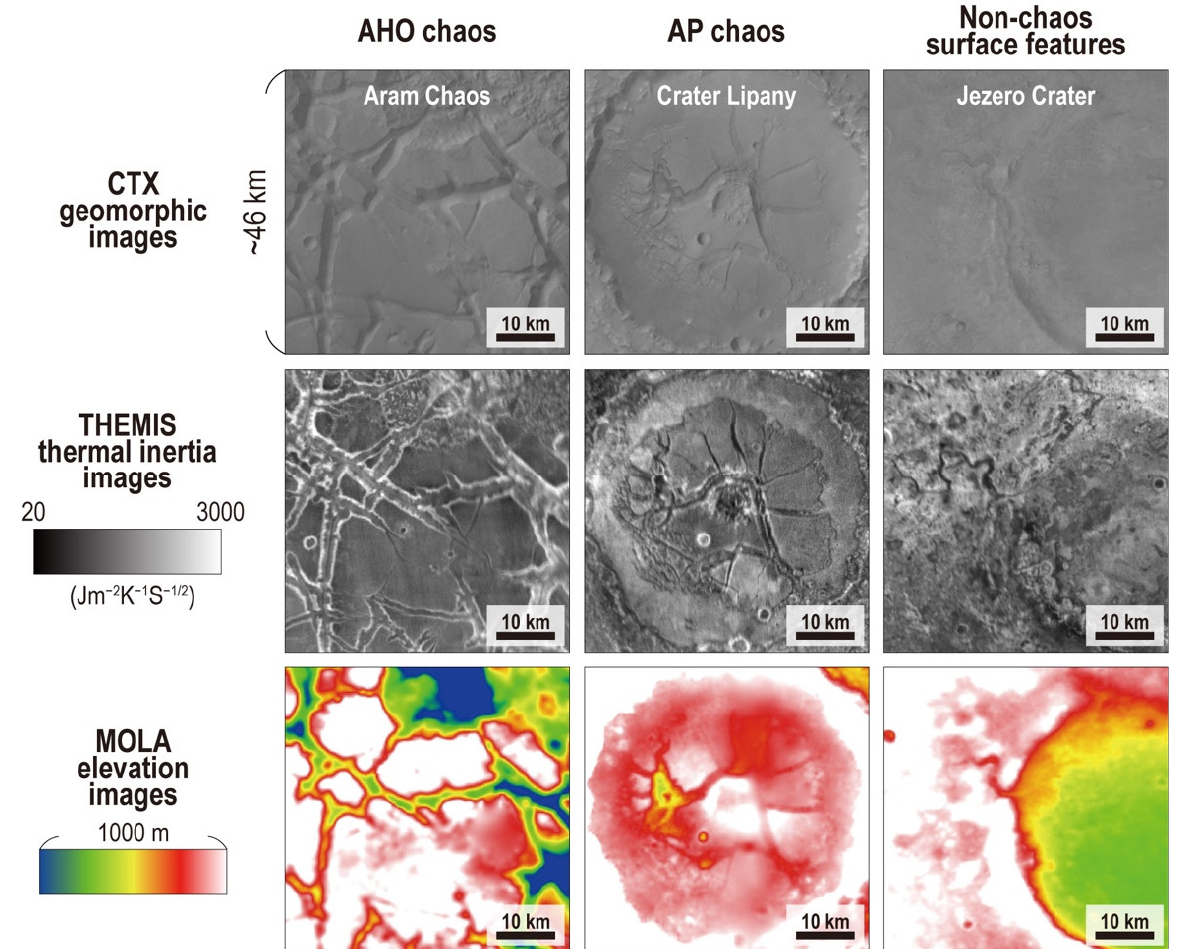
Figure 5. Comparison of typical CTX geomorphic, THEMIS thermal inertia, and MOLA elevation images for AHO chaos blocks (Aram Chaos), AP chaos blocks (Crater Lipany), and non-chaos surface features (Jezero Crater) used as training data before normalization of pixel values (see the text for details).